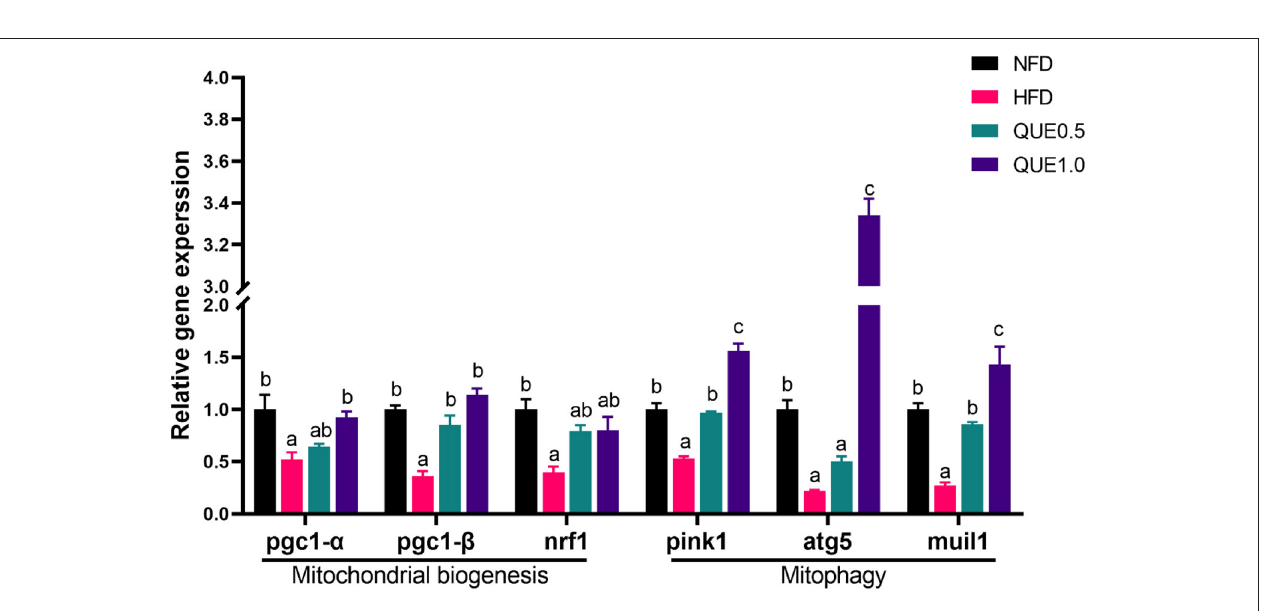
T-AOC and reduced the contents of MDA and ROS ( Figure 4